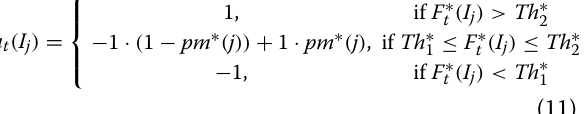
apart from Th 1 by the amount of dispersion of the fea- ture value. This constraint seems to be reasonable since a large dispersion implies somewhat mixed class member- ships of data in general. With the constraint of Eq. (10), our Fuzzy Adaboost algorithm needs to search for the optimum feature and Th 1 in each round. It could reduce the computation time very